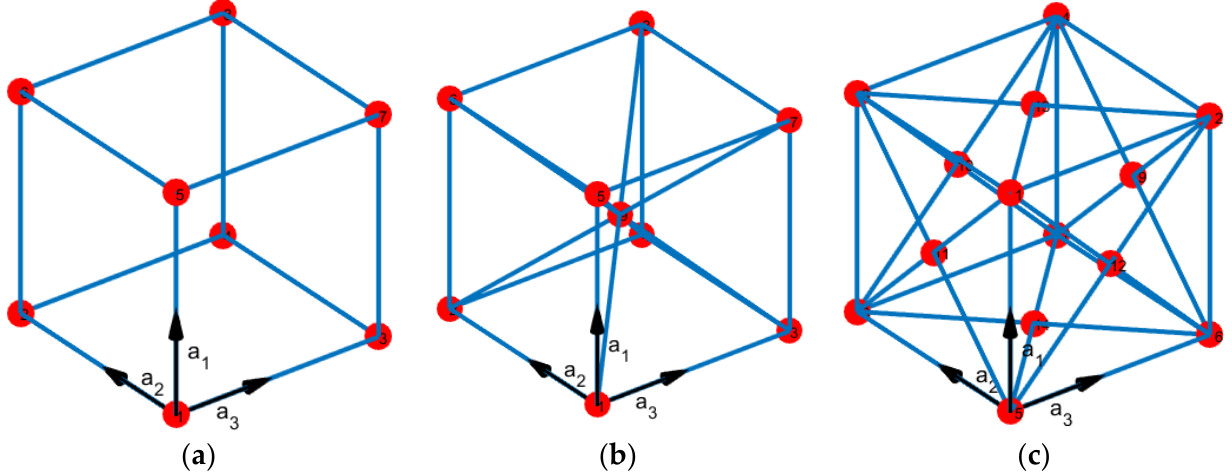
Figure 2. Bravais cubic lattices ( a ) cubic/primitive, ( b ) body-centered cubic (BCC), and ( c ) face-centered cubic (FCC).